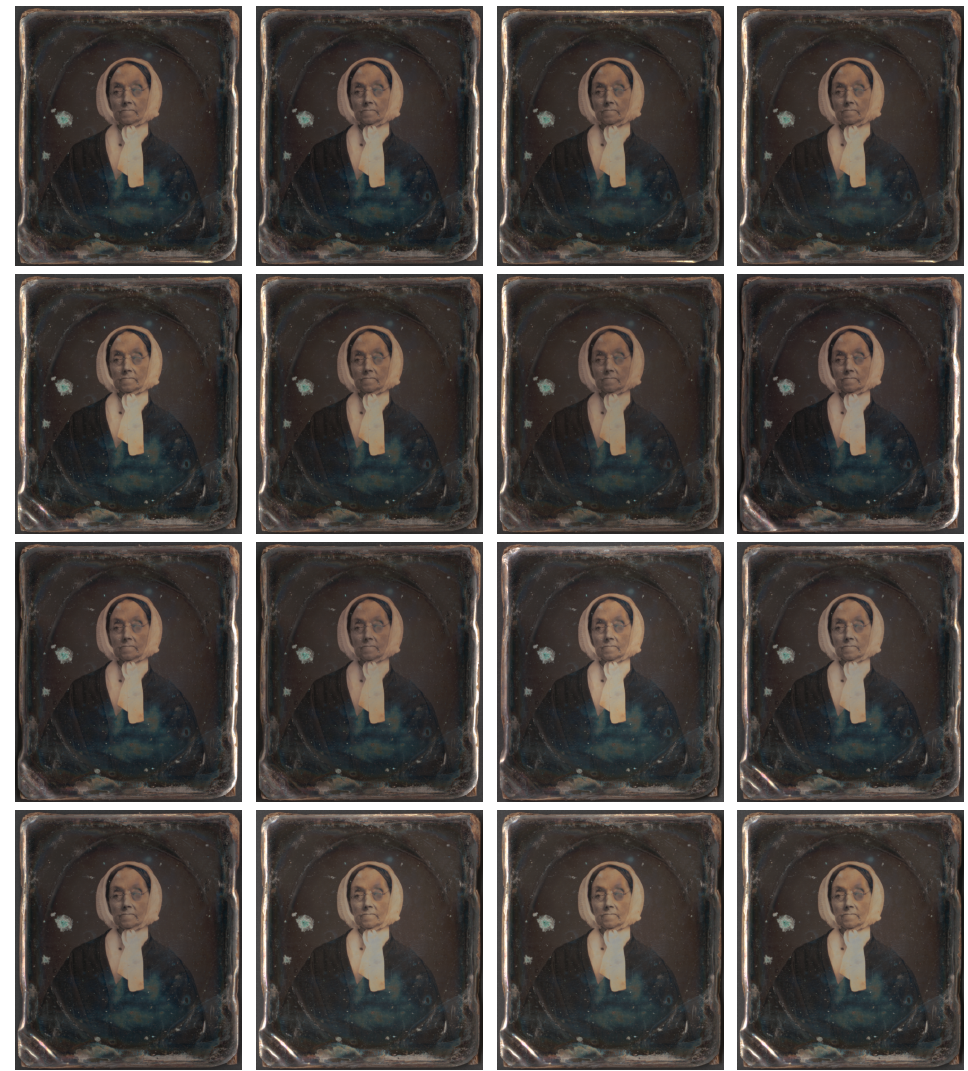
Figure A2. Images of daguerreotypes scanned with different light modes. From left to right: LRFB , LR , LFB , LF , LTx , LTx 5cm , LTx 10cm , RTx , RTx 5cm , RTx 10cm , LLa , LRFB 15deg , LR 15deg , LFB 15deg , LF 15deg , L 15deg